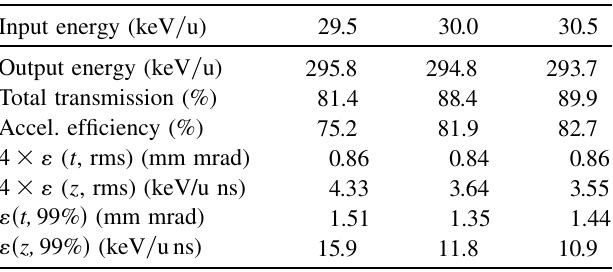
TABLE VII. Effect of varying the input beam energy on the output beam parameters.